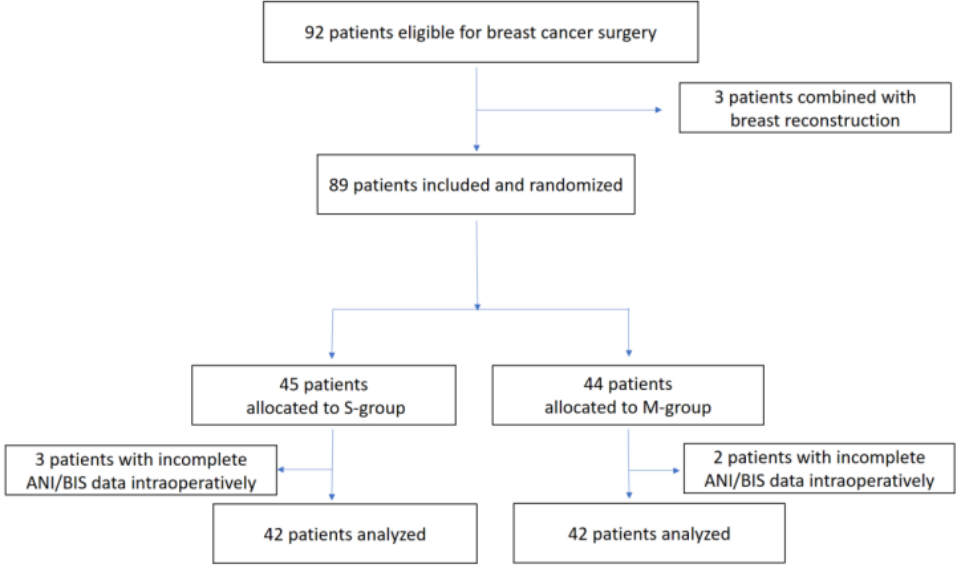
Figure 1. Flow diagram showing participants included in the analysis for the study. Table 1. Patients’ demographic characteristics, surgical procedures, and various time intervals. Variables